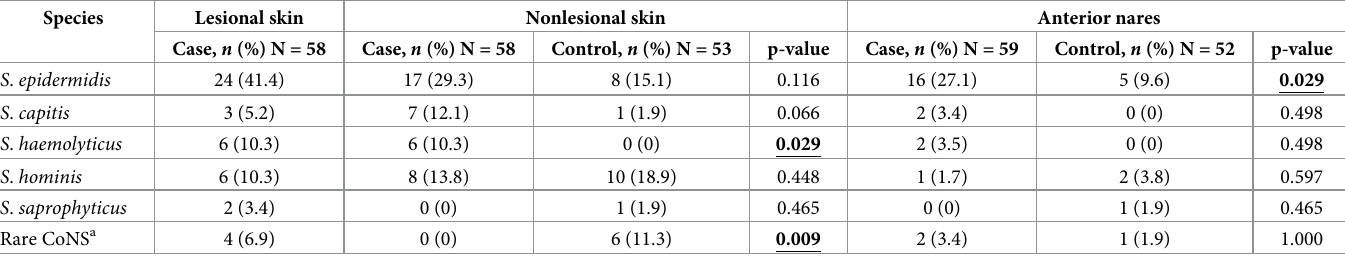
Table 2. CoNS species identified on the skin and anterior nares of Umthatha (rural) cases and controls. Species